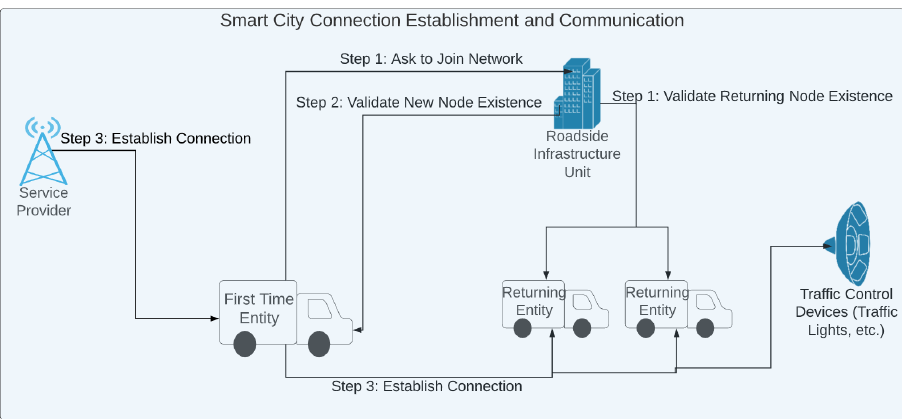
Figure 9. An example of a smart city infrastructure where all nodes, or entities, are capable of processing information and contributing resources to the overall network.